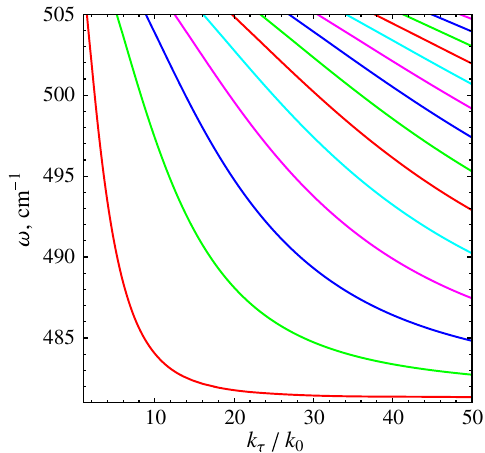
FIG. 10. The wave dispersion ω ð k τ Þ for the surface states at the interface of a silicon-sapphire hypercrystal with air in the zero loss limit; the unit cell of the composite is formed by silicon and ¼ d ¼ 1 μ m. Note that for all sapphire layers of equal widths, d h i modes, (i) k τ > k 0 (as the coordinate axis origin corresponds to k τ =k 0 ¼ 1 ), so that they are outside the free-space “ light cone ” k τ < k 0 and therefore cannot directly couple to the air, and (ii) the < 0 . group velocity v g